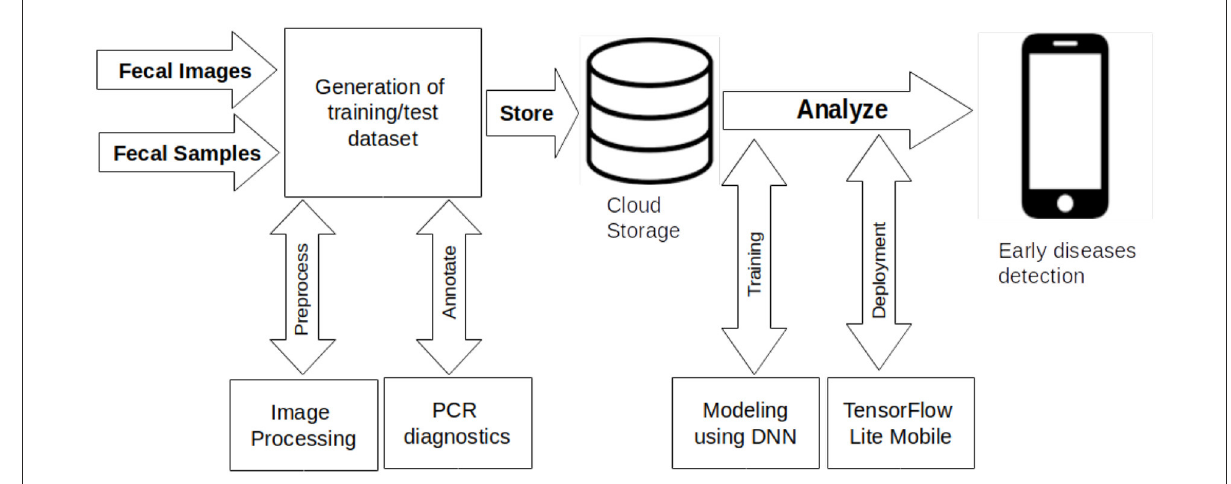
FIGURE2 Automated poultry disease diagnostics research